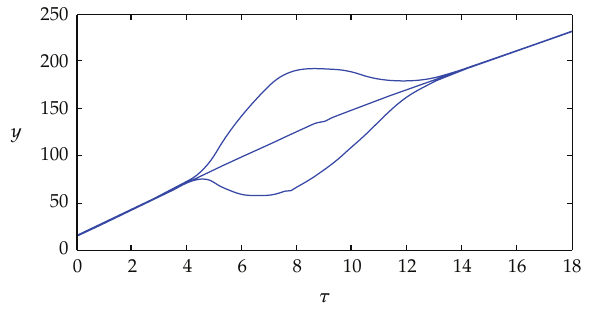
Figure 5: Bifurcation diagram for τ